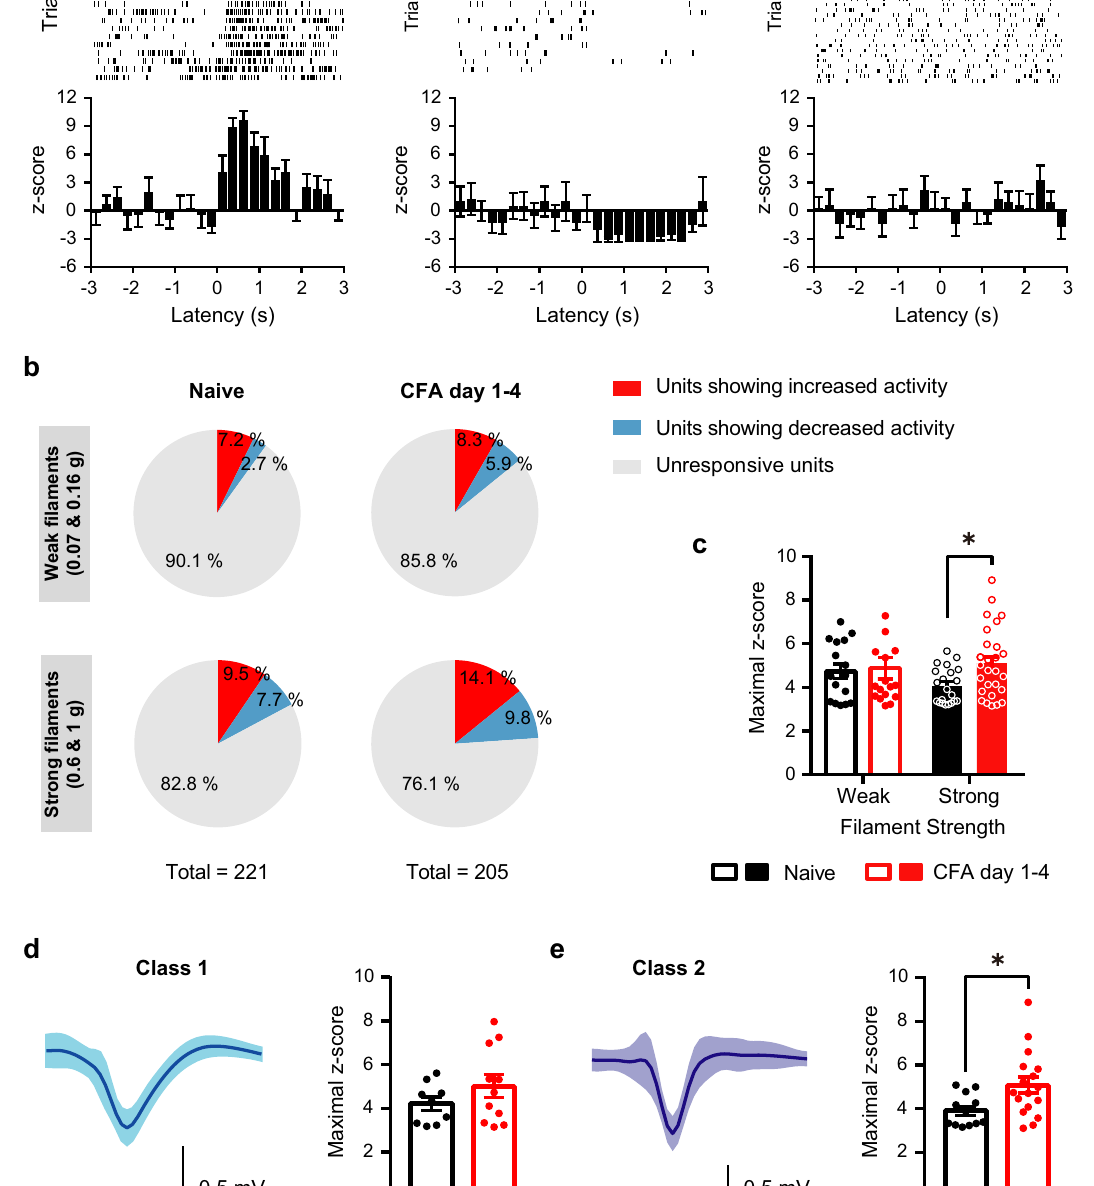
during hindpaw CFA-induced peak in fl ammatory pain-like behavior (day 1 – 4). c – e The maximum enhancement of activity over average baseline values for unitsexcitedbymechanicalstimulationisdemonstratedinnaivemiceandpost- CFA.In d , e ,unitsaresubdividedintoclass1( d )andclass2(fastspiking; e )types of neurons based on waveform. n =5 mice/group; * P <0.05 (0.0412 in c ; 0.0191 in e ), two-way ANOVA with Sidak ’ s multiple comparisons test ( c ), and unpaired two-tailed t test ( d , e ). Data are presented as mean +/ −